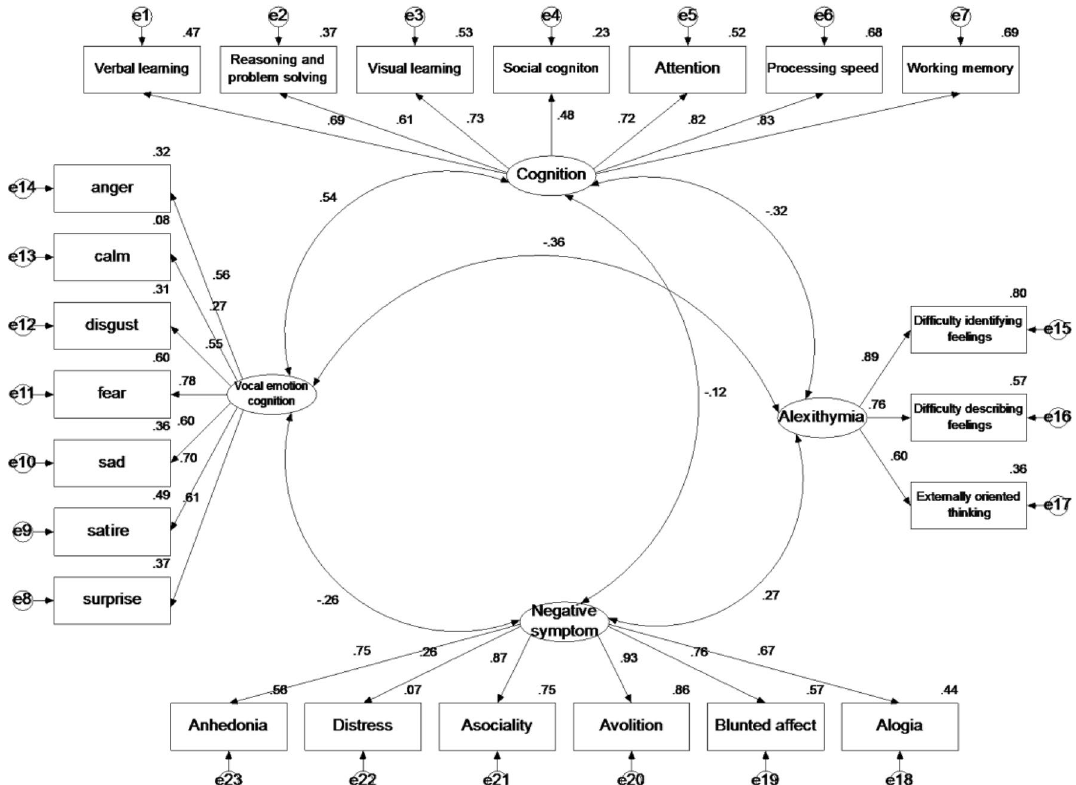
Figure 1. Model 0: Measurement Model. Circles represent unobserved latent variables. Rectangles represent observed measured variables. Values are standardized path coefficients. The figure reflects a measurement model that shows the degree of fit between the four latent variables (neurocognition, vocal emotion cognition, alexithymia, and negative symptoms) and their respective